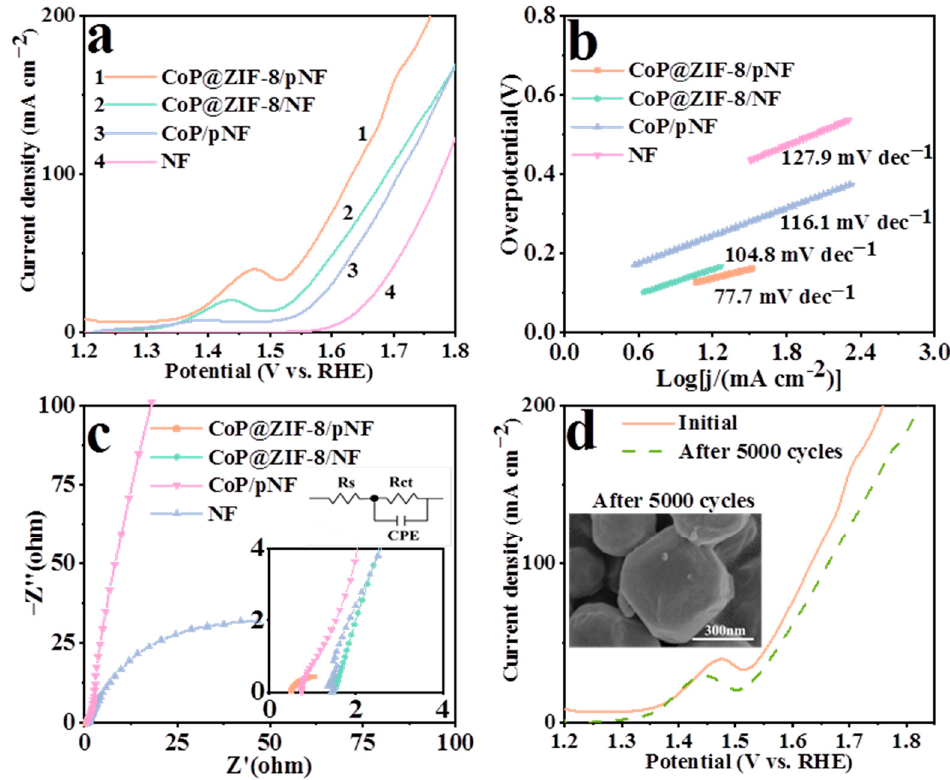
Figure 9. LSV curves ( a ), the corresponding Tafel plots ( b ) and EIS test ( c ) for OER of CoP@ZIF-8/pNF, CoP@ZIF-8/NF, CoP/pNF and bare NF in 1.0 M KOH. ( d ) LSV for OER